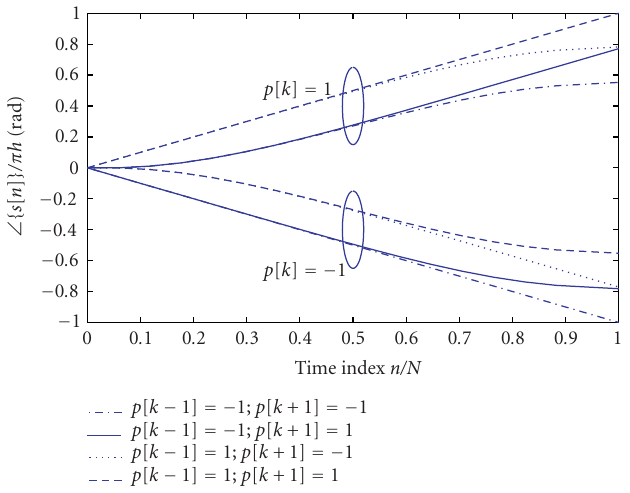
Figure 6: Example of the possible phase trajectories of s [ n ] for one bit period for L =